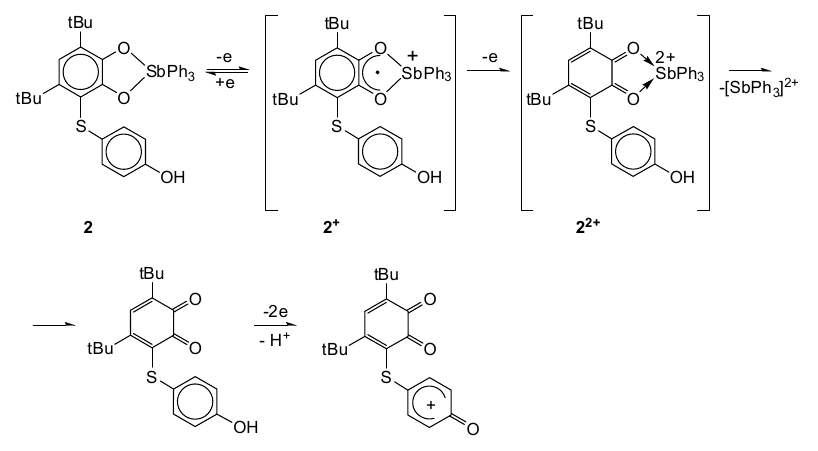
Scheme 6. The electrochemical oxidation of complex 2 .